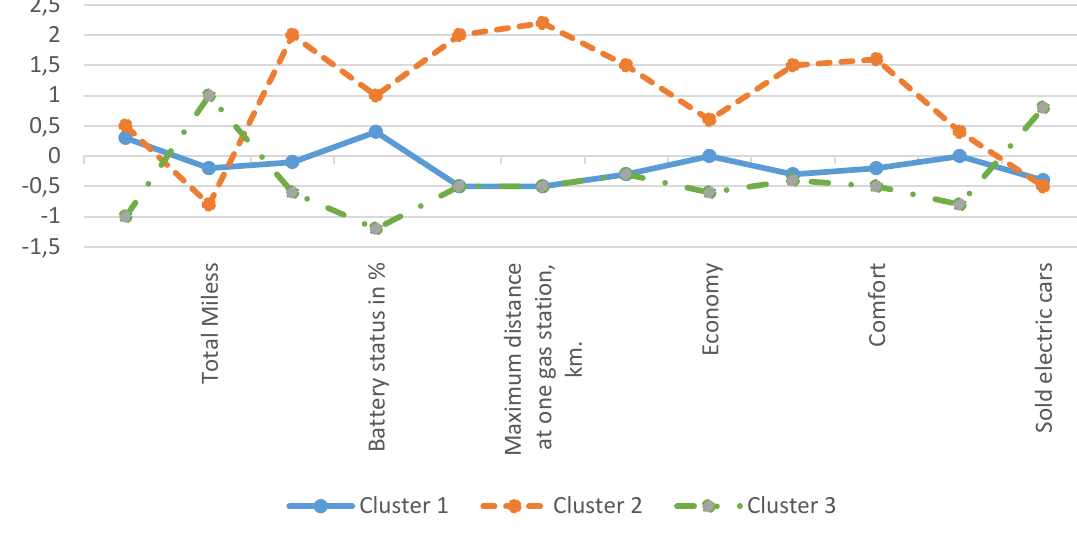
Figure 4. Cluster analysis results